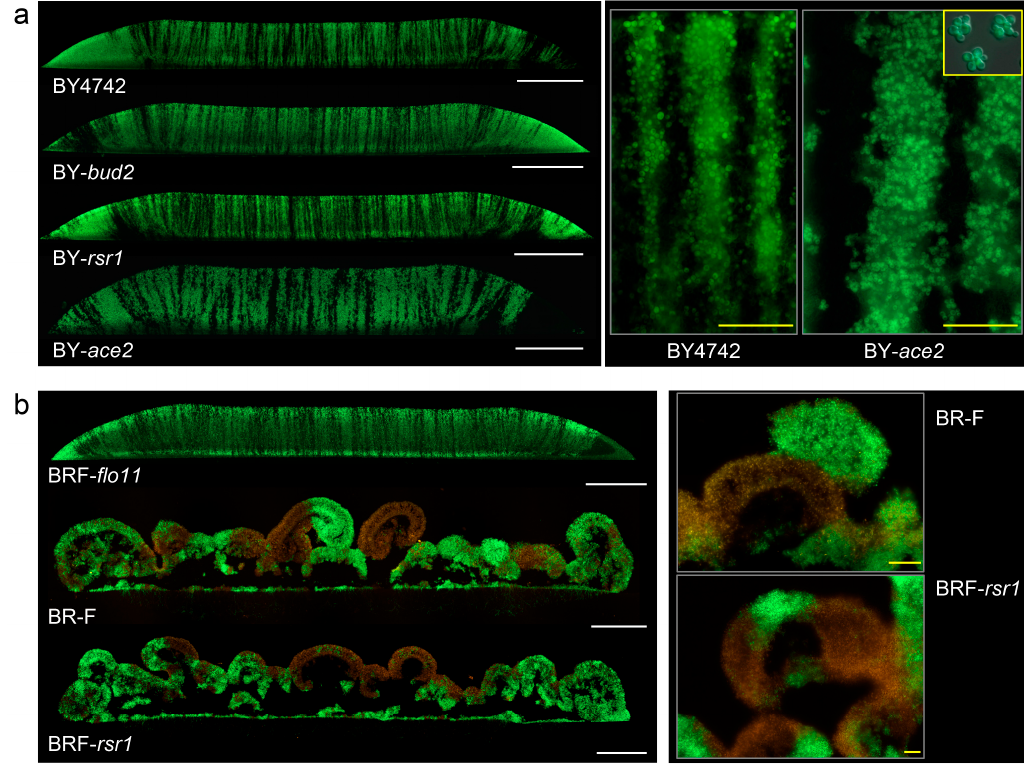
Figure 4. The effect of impaired budding polarity, cell separation, and cell adhesion on the formation of chimeric giant colonies and colony biofilms. ( a ) Cross-sections of chimeric colonies formed by knockout (KO) strains as indicated, derived from BY4742; the BY4742 colony is shown as a control. Details of BY- ace2 stripes as compared to BY4742 stripes are shown in the right panel. Inset (yellow rectangle), individual clusters of non-separated BY- ace2 cells grown in GM liquid medium. White bar, 500 μ m; yellow bar, 50 μ m. ( b ) Whole cross-sections of chimeric colony biofilm formed by KO strains in gene RSR1 or FLO11 derived from BR-F; BR-F colony biofilm as a control (white bar, 500 μ m), and examples of aerial parts in higher magnification (right; yellow bar, 100 μ m). 1 μ l drops of 10 8 cells/mL were used for inoculation.